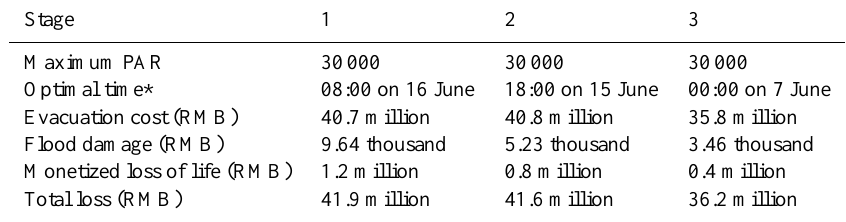
Table 8. The optimal decision and flood consequences in Beichuan Town.